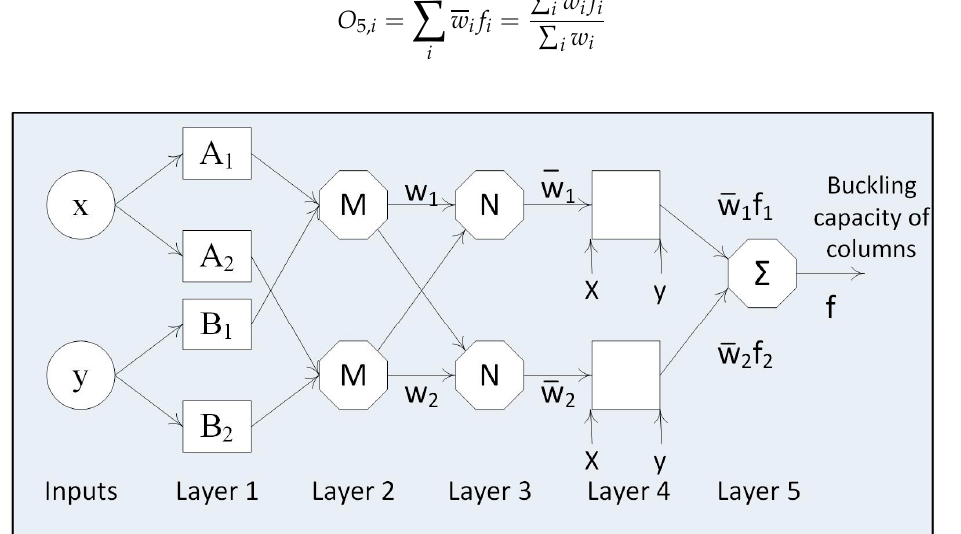
Figure 1. Architecture of Adaptive Neuro-Fuzzy Inference System (ANFIS) technique.